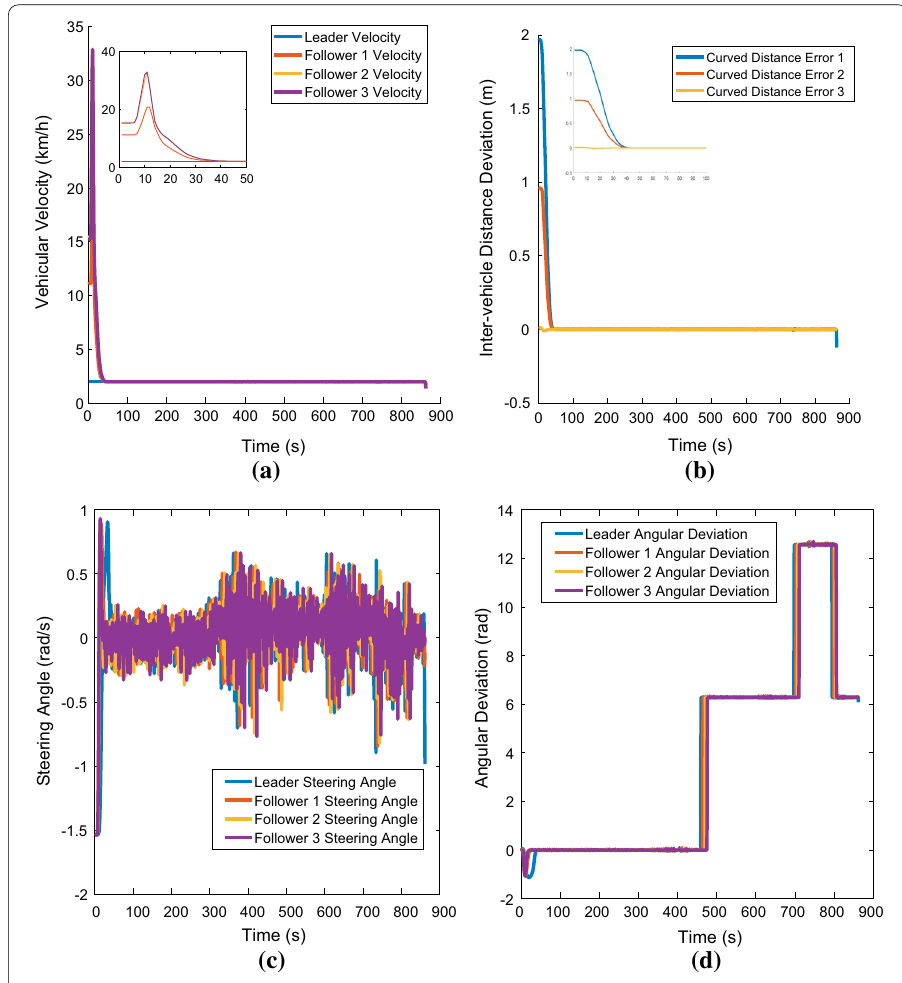
Fig. 5 Decentralized control under PF: a Vehicular velocity; b Vehicular distance error; c Steering Angle; d Angular Deviation